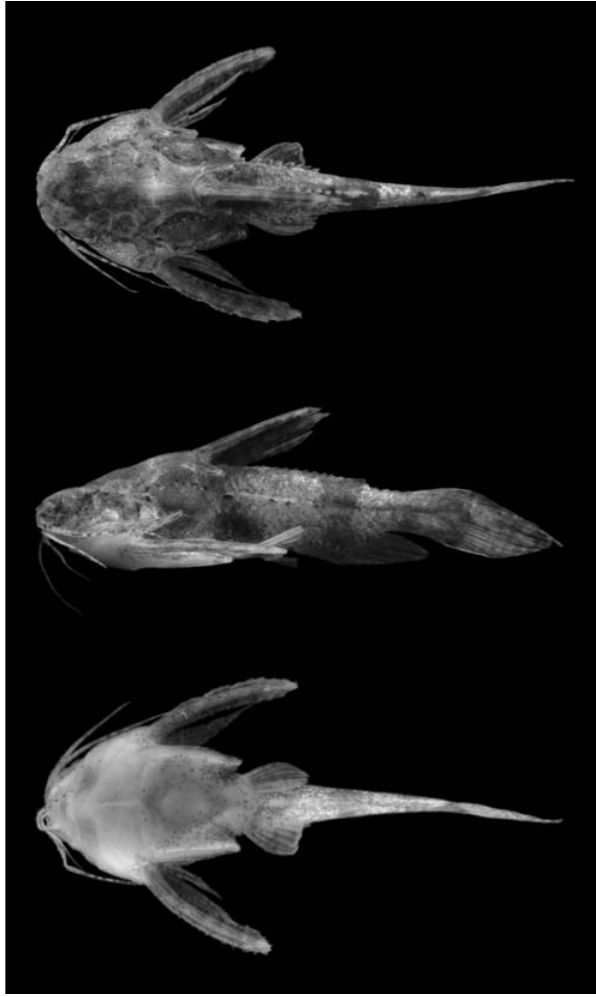
SL), mouth of igarapé Zamula, rio Negro, Amazonas State, Brazil.